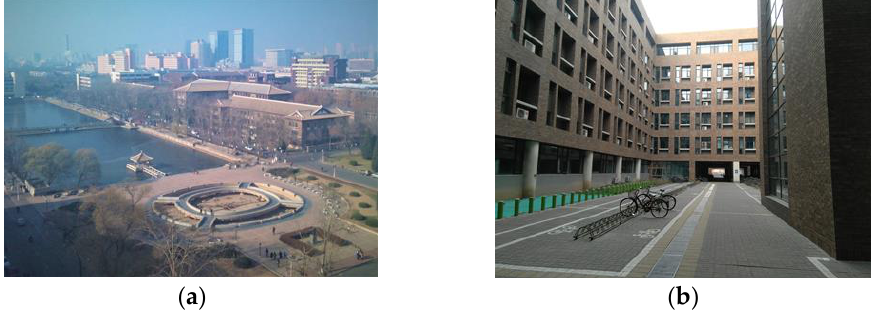
Figure 2. Beiyang square ( a ) and the center of No. 26 Building ( b ). (Photo source: Baidu search and shooting by the author.)